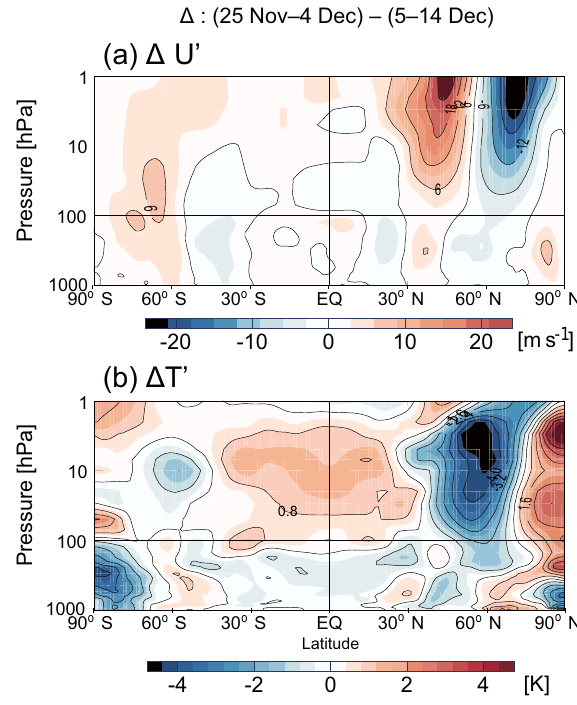
Figure 2. Difference between the mean values from 25 Novem- ber to 4 December 2011 and from 5 to 14 December 2011 for (a) anomalous zonal-mean zonal wind and (b) anomalous zonal- mean